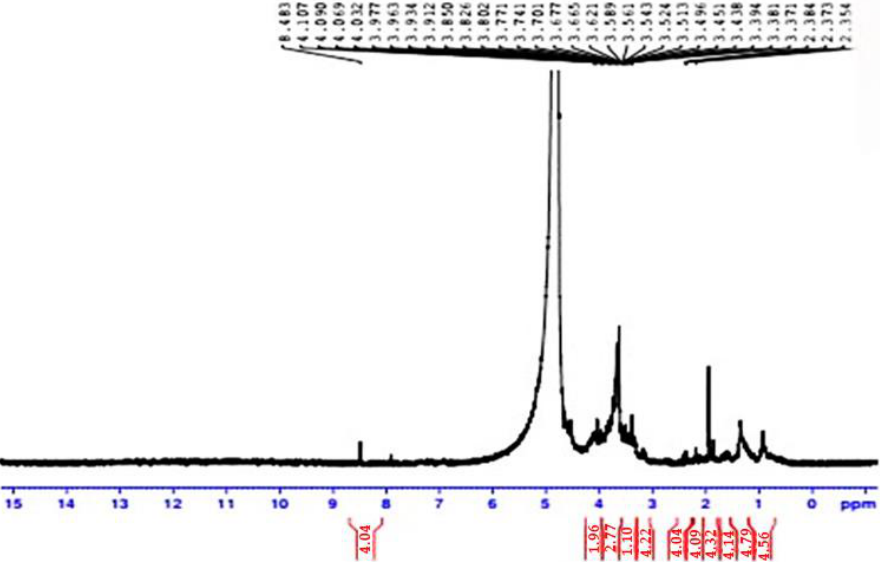
Figure 6. 1 H NMR spectra show the structure of isolated polysaccharides from Delonix regia.